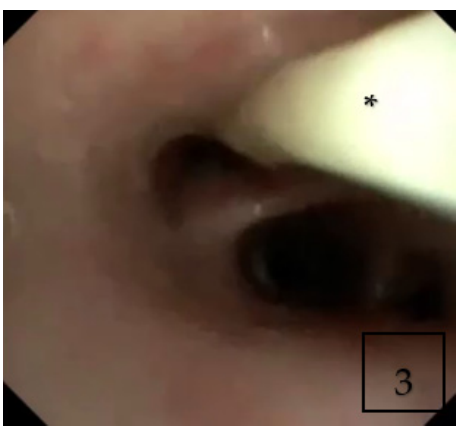
Figure 3. Flexible bronchoscopy showing thick purulent secretions (Asterisk *) in right middle lobe. Table 1. The patient’s Clinical Symptoms, Pulmonary Function Tests, and Serological Parameters.